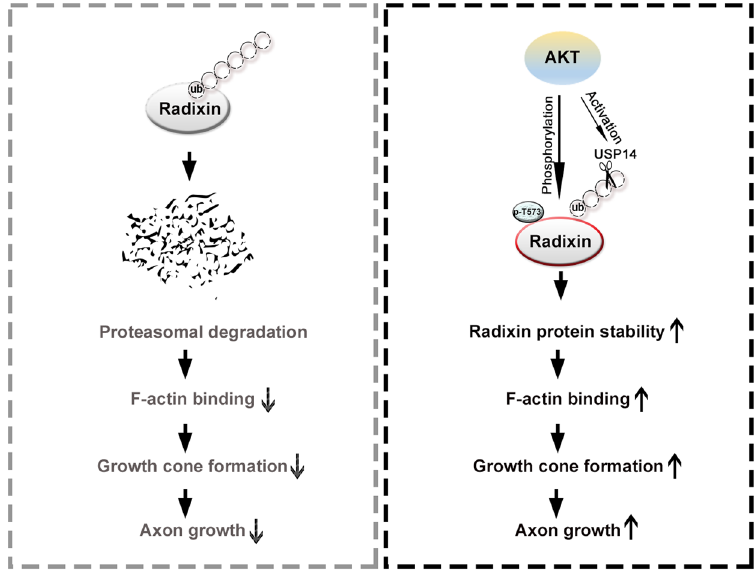
Figure 6. Schematic diagram of Akt/radixin signaling in neurons. Akt-mediated phosphorylation of radixin at T573 augments protein stability and radixin interaction with F-actin, thereby promoting neurite growth in developing